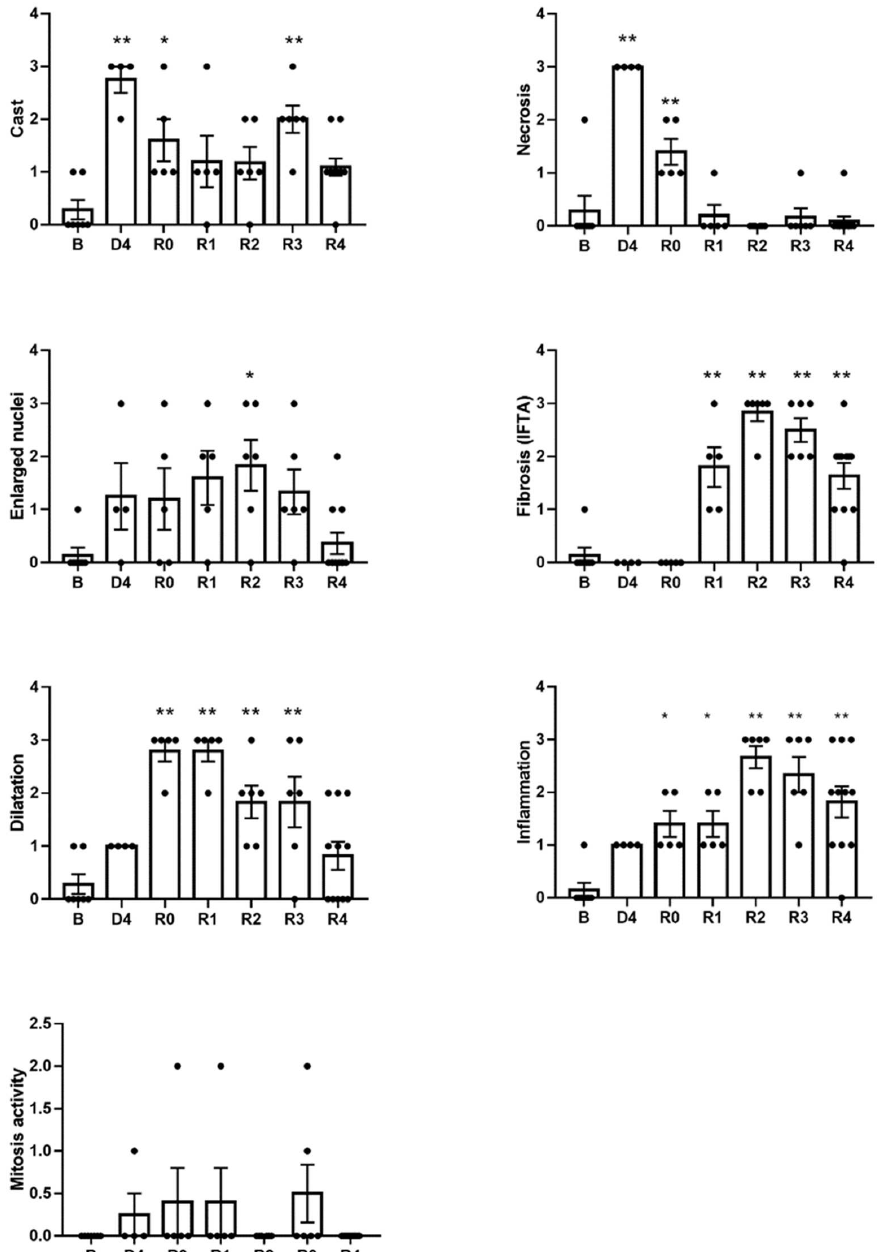
Figure 5. Score of several parameters of histological damage based on haematoxylin–eosin and periodic acid–Schiff staining. B: basal; D4: day of maximum kidney damage after cisplatin treatment; R0: day of recovery; R1: 1 week after recovery; R2: 2 weeks after recovery; R3: 3 weeks after recovery; R4: 4 weeks after recovery. * p < 0.05 vs. B; ** p < 0.01 vs. B. 3.2. KIM-1 Urinary Excretion Remains Elevated Three Weeks after the Apparent Normalization of Renal Function Both urinary KIM-1 excretion and concentration are significantly increased on the day of maximum AKI (D4), but still increase and peak by R0 (i.e., at ClCr normalization). Urinary KIM-1 levels remain significantly elevated even three weeks afterwards, by